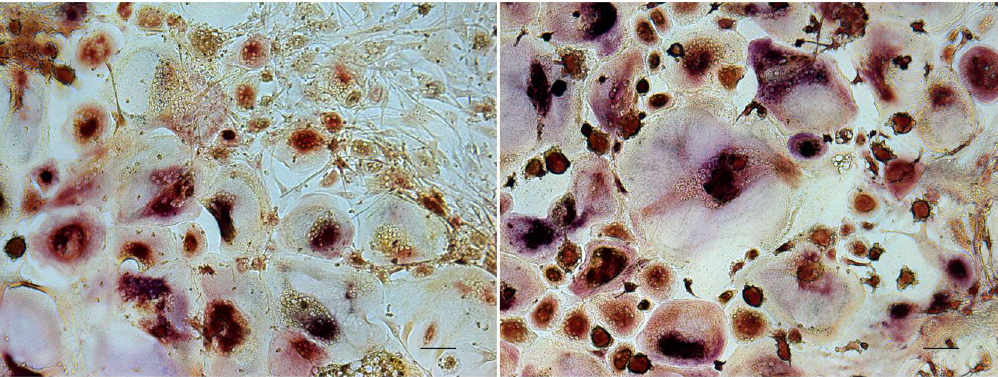
Figure 2. TRAP staining of PBMC / PPF (periprosthetic fibroblast-like cells) co-cultures on conventional culture plates on day 28. TRAP positive MNCs of various sizes surrounded by TRAP negative, spindle-shaped cells. Bar represents 50 µm.